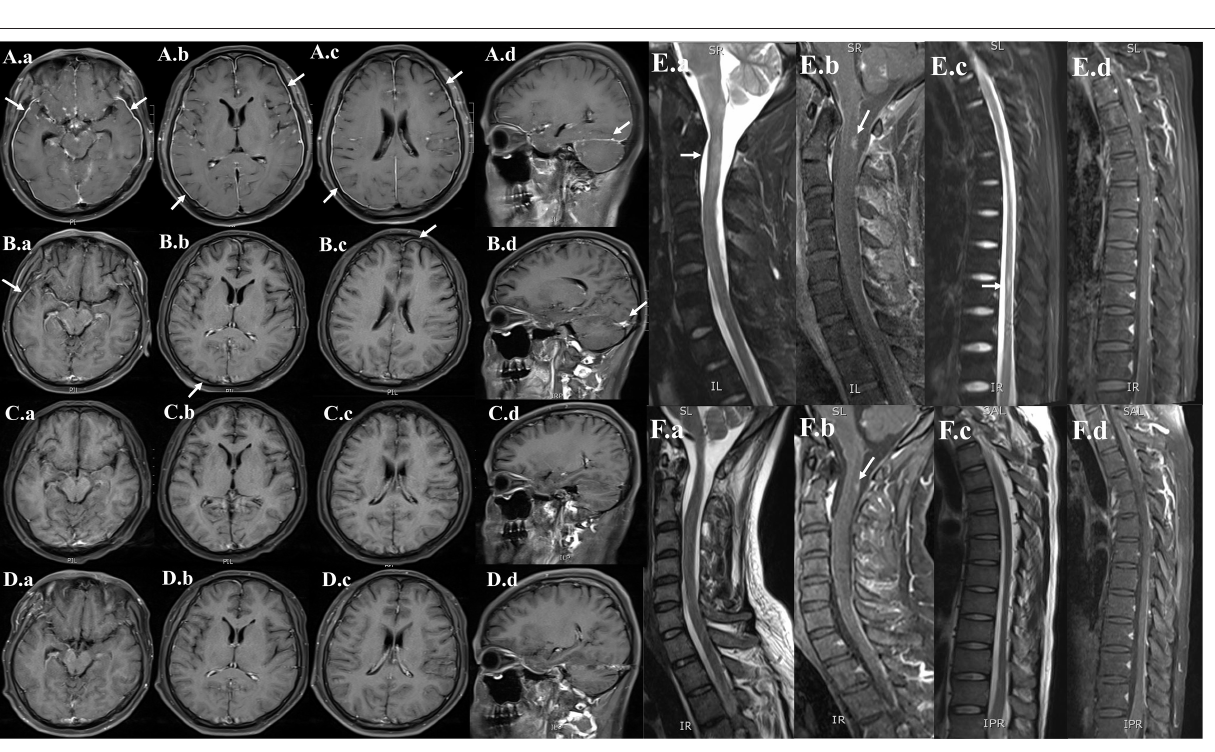
FIGURE 3 | Serial neuroimaging with MRI demonstrating lesion amelioration. (A) Contrast-enhanced MRI brain (hospital day 5), (a,b,c) axial and (d) sagittal T1-weighted images showing diffuse leptomeningeal and pachymeningeal contrast enhancement (white arrows). (B) Repeat MRI on hospital day 29, (a,b,c) axial and (d) sagittal views showing less meningeal enhancement after 3 weeks of therapy. (C) Repeat MRI on the time of discharge (hospital day 62), (a,b,c) axial and (d) sagittal views showing the obvious resolution of the previous meningeal enhancement. (D) Repeat MRI on 6-month follow-up (a,b,c) axial and (d) sagittal views showing no meningeal enhancements. (E) MRI of the cervical and thoracic spine (hospital day 5), (a,c) sagittal T2-weighted and (b,d) post-contrast T1-weighted showing abnormal longitudinally extensive T2 weighted hyperintensities involving the C2–C3 and T6–T9. Partial enhancement was observed in the dorsal aspect of the spinal cord at C2 and T6–T7 levels (white arrows). (F) Repeat MRI on hospital day 29, (a,c) sagittal T2-weighted and (b,d) post-contrast T1-weighted images showing lesser abnormal hyperintensities compared with